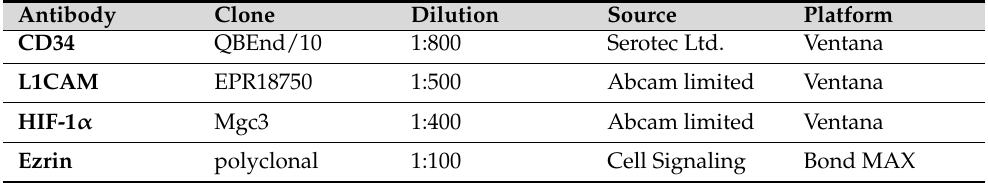
Table 6. Details of immunohistochemical